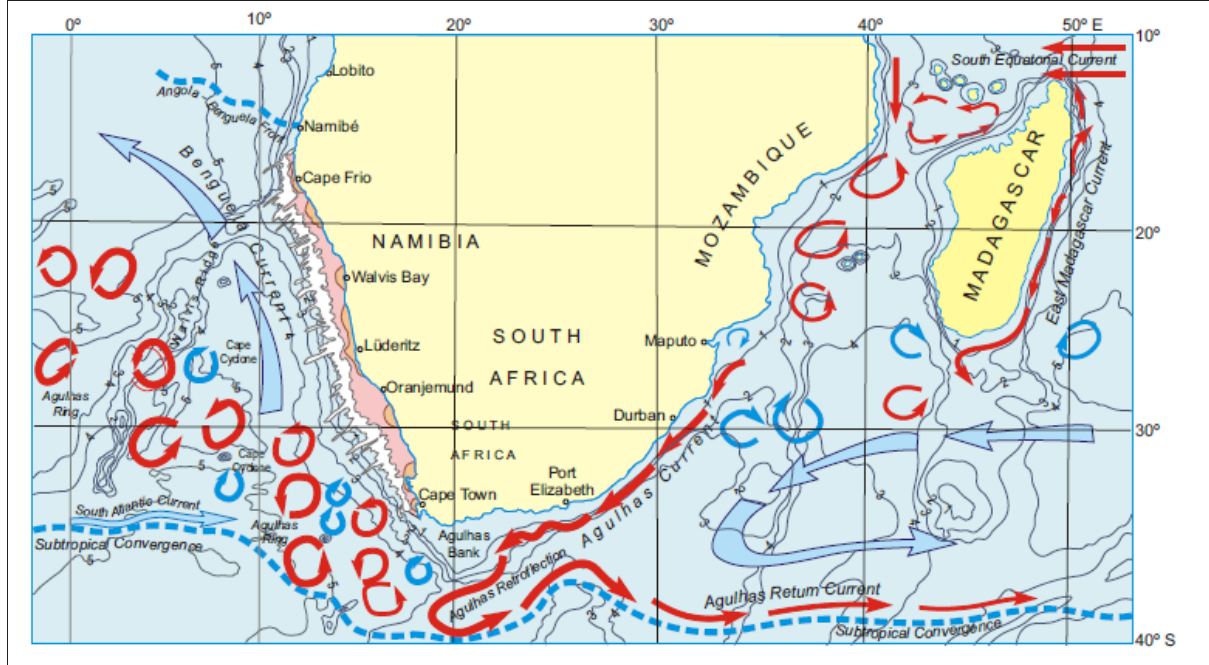
Figure 1: The Greater Agulhas Current System, showing the source regions of mesoscale eddies from the Mozambique Channel and East Madagascar Current and the recirculation of Agulhas Return Current, the Agulhas Retroflection and shedding of rings and filaments into the South Atlantic and the relative position of the Subtropical Convergence in the Southern Ocean (after Lutjeharms 1 )